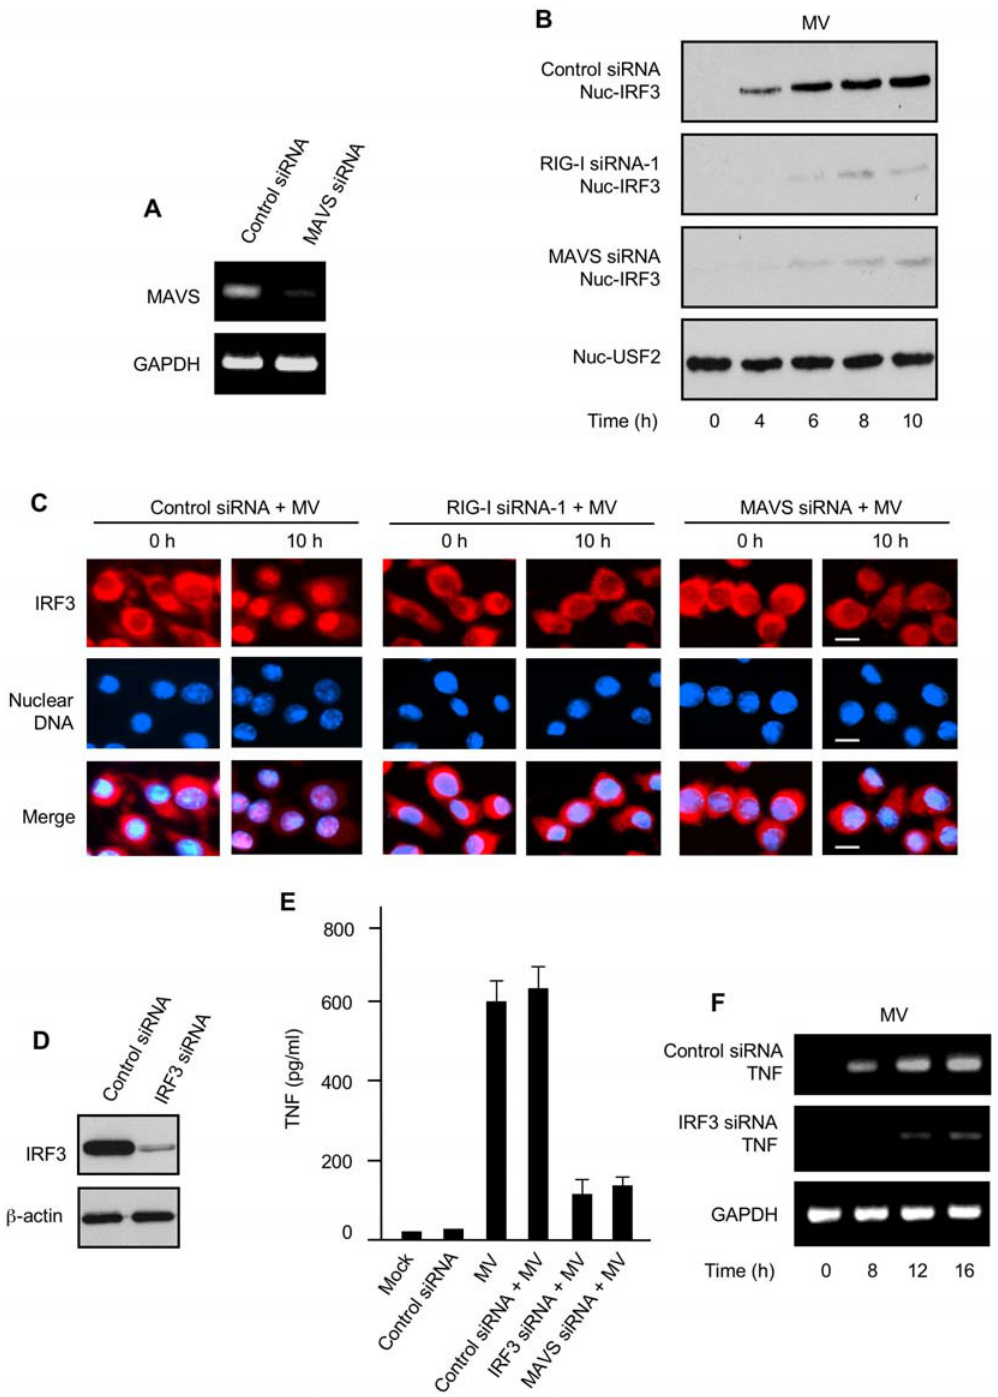
Figure 4. IRF3 is critical for triggering MV-elicited TNF induction in primary human macrophages. (A) pHMs were transfected with control siRNA or MAVS siRNA. The cells were analyzed 48 h later by RT-PCR for the indicated mRNA levels. GAPDH was used as the control. (B) Control siRNA pHMs or RIG-I siRNA or MAVS siRNA pHMs as indicated were infected with MV for various times (below lanes) and the nuclear extracts were probed for nuclear IRF3 (nuc-IRF3). Nuclear USF2 (nuc-USF2) was used as nuclear protein loading control. (C) Control siRNA pHMs or RIG-I siRNA or MAVS siRNA pHMs as indicated were infected with MV for 0 h or 10 h and were immunofluorescence-stained for IRF3 (red). Nuclear DNA was counterstained with DAPI (blue). Bars are 10 m m. (D) pHMs were transfected with control siRNA or IRF3 siRNA as indicated and were analyzed 72 h later by immunoblotting for IRF3 protein levels. b -actin was used as control. (E) pHMs or various siRNA pHMs as indicated were infected with MV for 24 h and TNF protein in the culture supernatants was assessed by ELISA. Data represent mean + / 2 SD. (F) Control siRNA pHMs or IRF3 siRNA pHMs were infected with MV for various times (below lanes) and the cells were analyzed by RT-PCR for the indicated TNF mRNA levels. GAPDH was used as control.